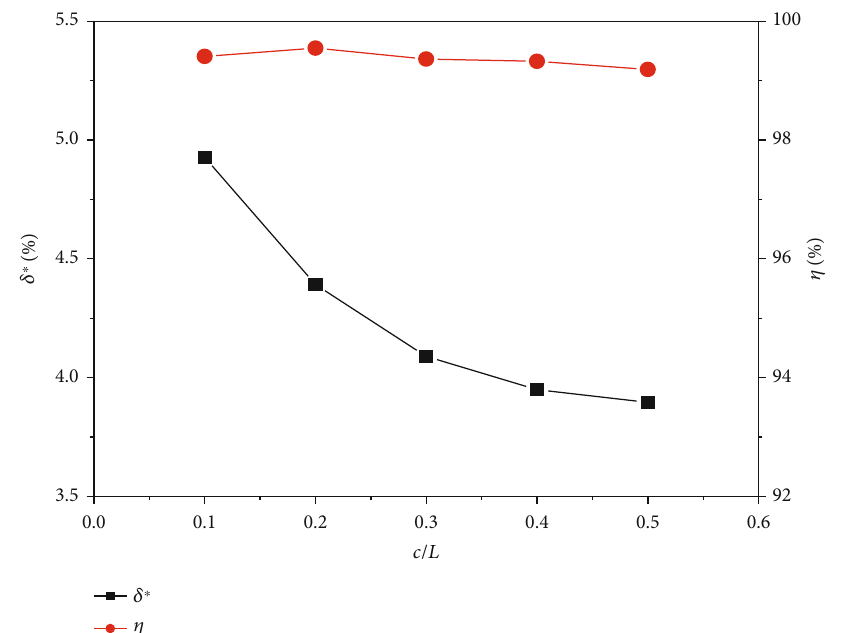
Figure 14: Total pressure loss and combustion e ffi ciency under di ff erent c / L .